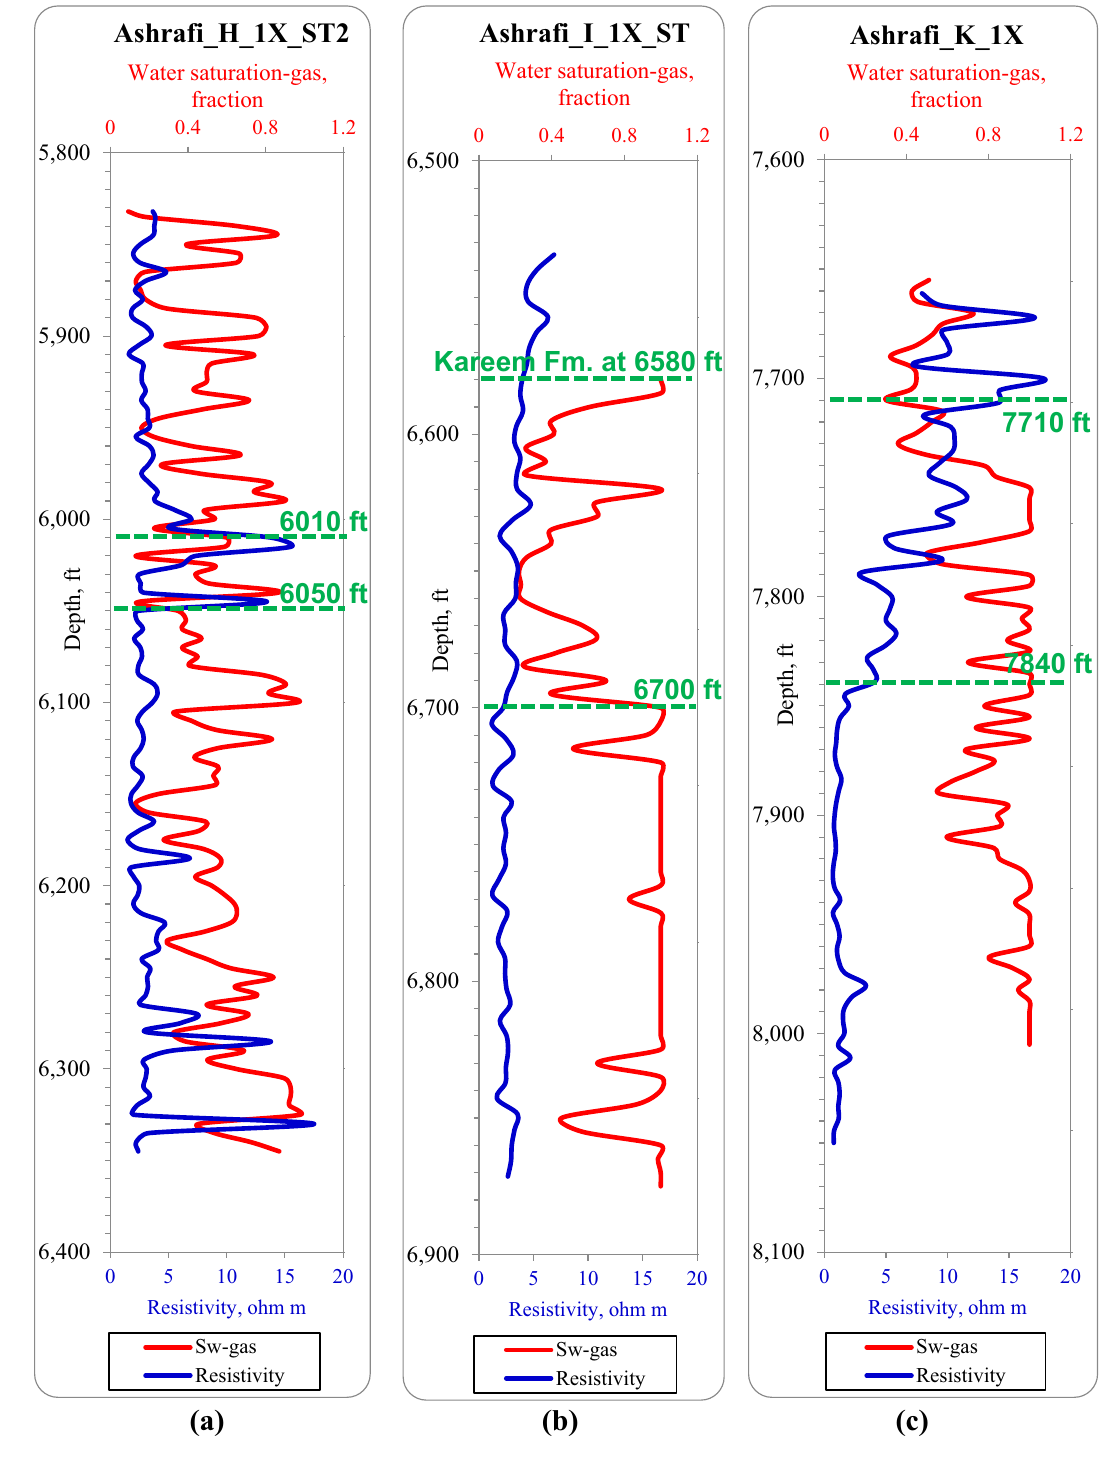
Fig. 9 Water saturation (Sw, fraction) from mud logging and resistivity ( R , ohm m) from wire-line logging with depth relationships